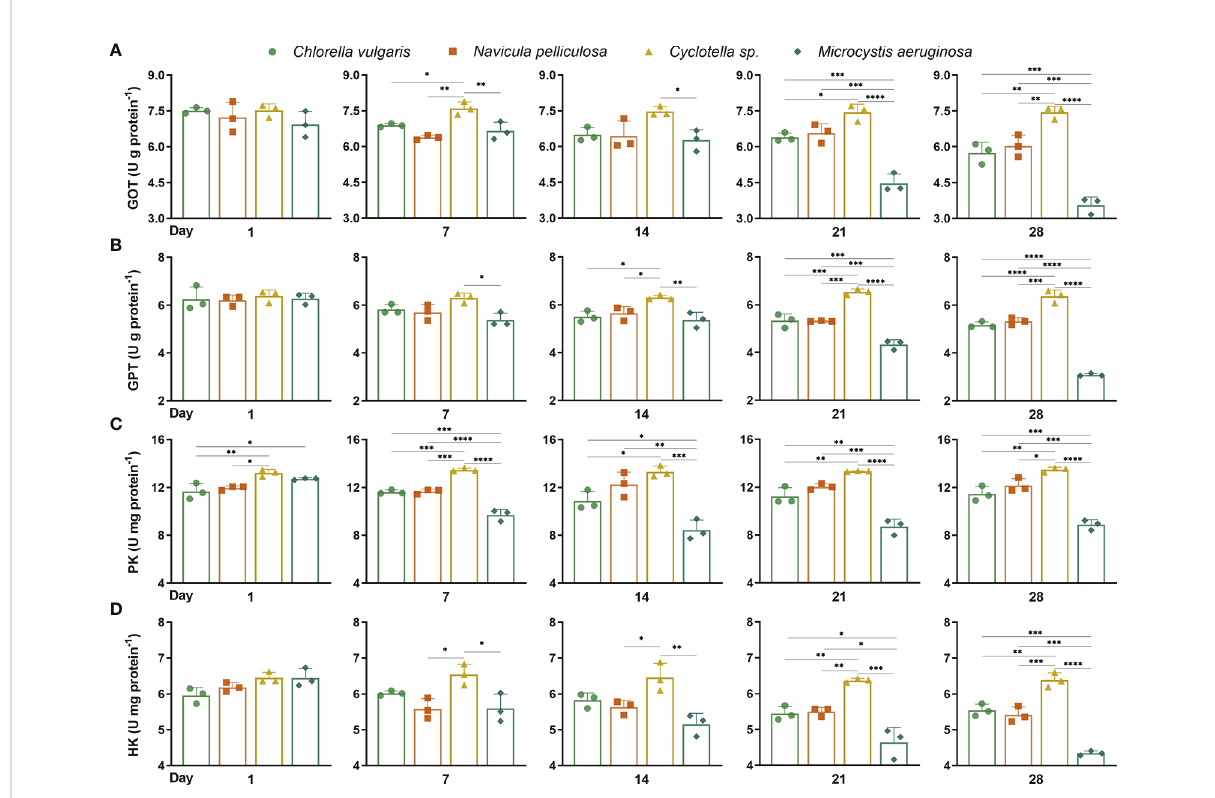
FIGURE 1 Activities of metabolic enzymes in liver of Hyriopsis cumingii . Mussels exposed to four different microalgae treatments on days 1, 7, 14, 21, and 28. (A) GOT, (B) GPT, (C) PK, and (D) HK. The asterisk (*) indicates signi fi cant differences between four microalgae treatments at each sampling time (Tukey test, p < 0.05). Values are expressed as mean ± SD (n = 3). GOT, glutamic oxaloacetate transaminase; GPT, glutamic pyruvate transaminase; PK, pyruvate kinase; HK, hexokinase. The symbols *, ** , *** and **** represent p < 0.05, p < 0.01, p < 0.001 and p < 0.0001